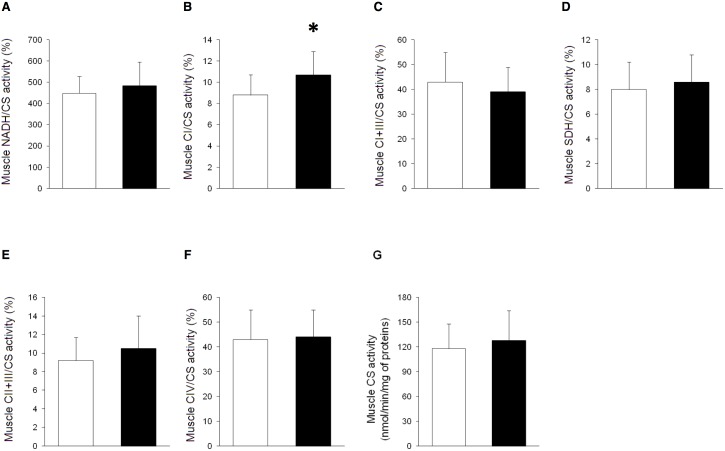
Skeletal muscle mitochondrial biochemistry during septic shock.Mitochondrial biochemistry was measured on triceps brachii muscle of ten surgical controls (white bars) and thirty patients with septic shock (<24 h from ICU admission) (black bars). Results of two patients are not available due to technical troubles. Activities of nicotinamide adenine dinucleotide dehydrogenase (NADH) (p = 0.369) (A), complex I (CI) (p = 0.021) (B), complex I and III (CI+III) (p = 0.286) (C), succinate dehydrogenase (SDH) (p = 0.432) (D), complex II and III (CII+III) (p = 0.273) (E) and complex IV (CIV) (p = 0.760) (F) are expressed as percentages of citrate synthase (CS) activity (p = 0.458) (G). Data are reported as means and standard deviations. *p<0.05 vs. controls (Student’s t test).